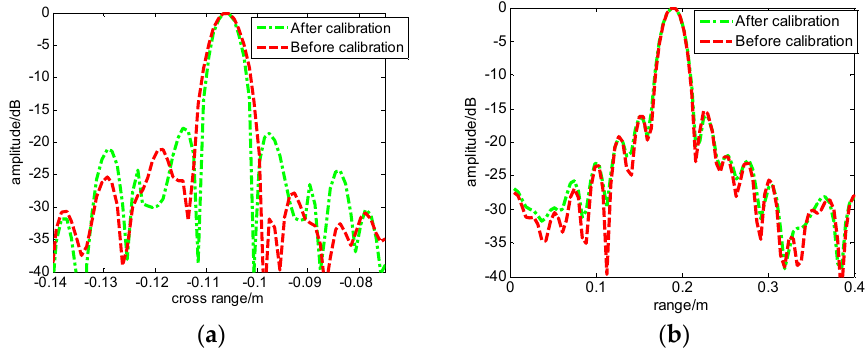
Figure 13. The PSF comparisons of the ball in experiments before and after calibration, ( a ) is the cross range PSF and ( b ) is the range PSF.